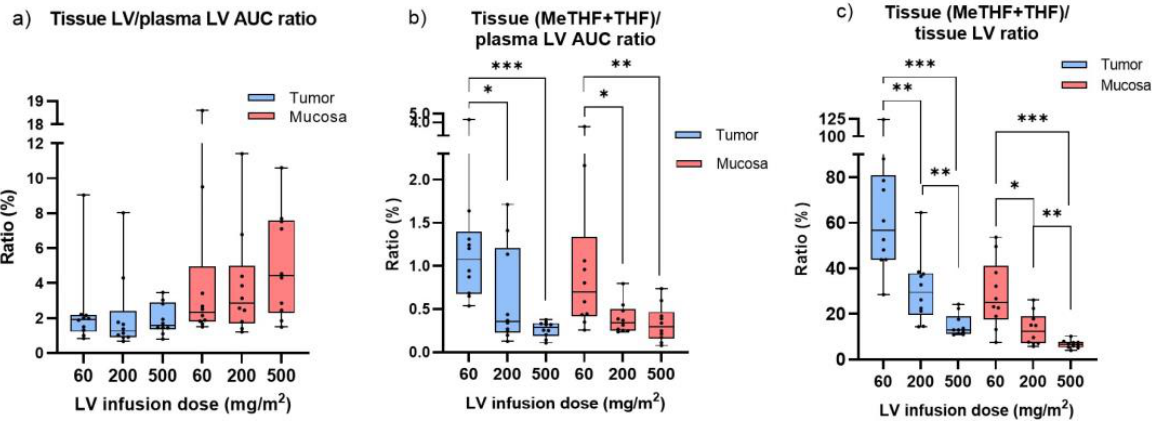
Figure 3. Relationship between ( a ) tissue LV level and plasma LV AUC, ( b ) tissue (MeTHF + THF) level and plasma LV AUC, and ( c ) tissue (MeTHF + THF) and LV levels, at different two-hour infu- sion dosages of LV. * p 0.05; ** p 0.01, *** p 0.001.